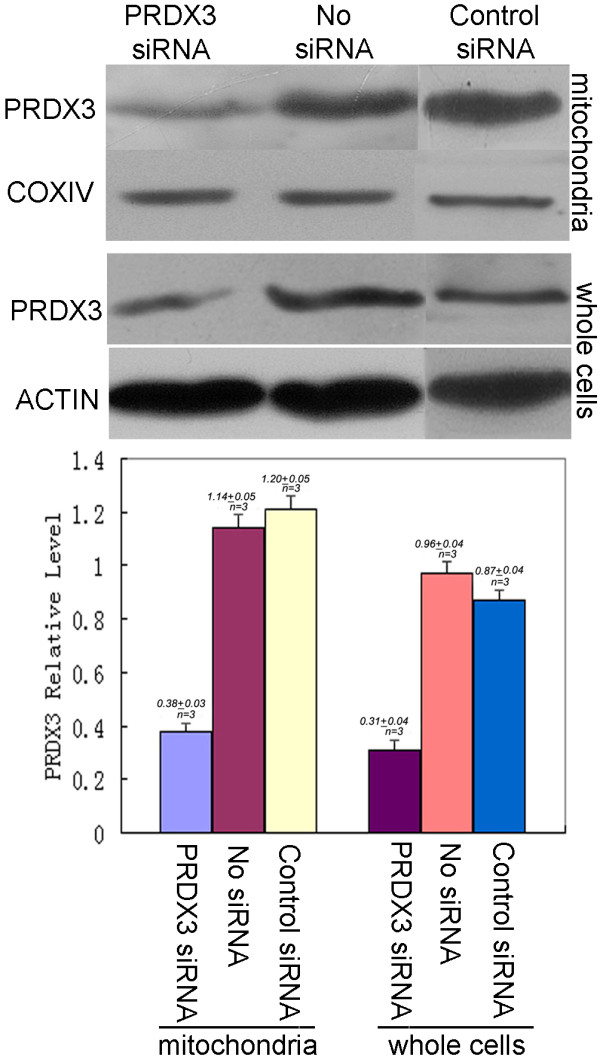
Effects of PRDX3 siRNA transient transfection on the PRDX3 expression of metastatic 5-8F cells. Suppression of PRDX3 expression in the levels of mitochondria and whole cells of the metastatic 5-8F cells treated with siRNA relative to without siRNA and control siRNA treatments. The top shows the Western blotting image. The bottom shows the quantitative comparison of the digitized Western blotting image. COXIV, a marker protein of mitochondria, was used as a reference standard protein when mitochondrial protein sample was analyzed with Western blot. ACTIN that is mainly expressed in the cytoplasm was used a reference standard protein when whole-cell protein sample was analyzed with Western blot. Western blot experiments were carried out triply (n = 3).